Question: Is the quantity shown trending increasing or decreasing?
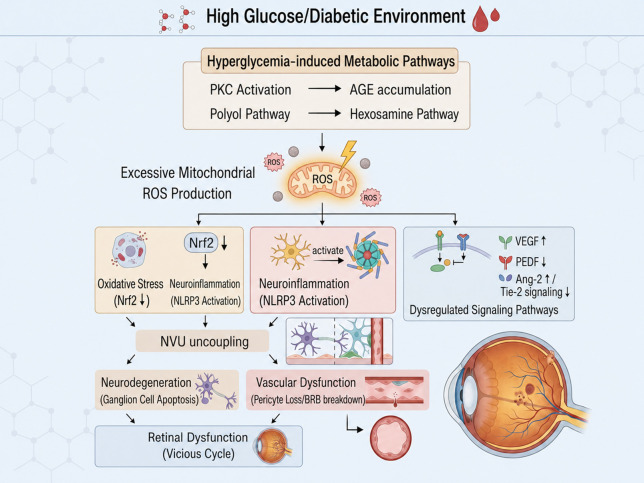
Answer: increasing